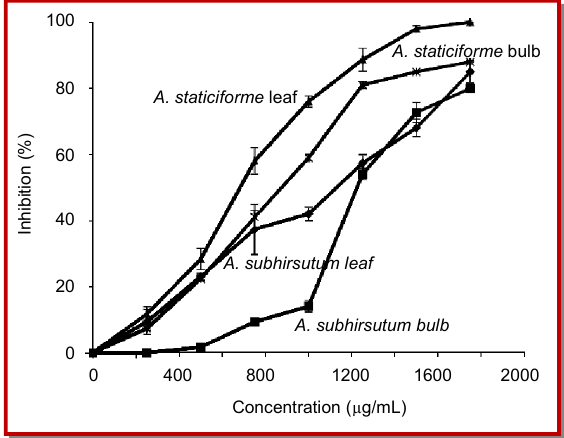
Figure 1: DPPH radical scavenging activity of A. staticiforme and A. subhirsutum Each value was represented as mean ± SEM of three